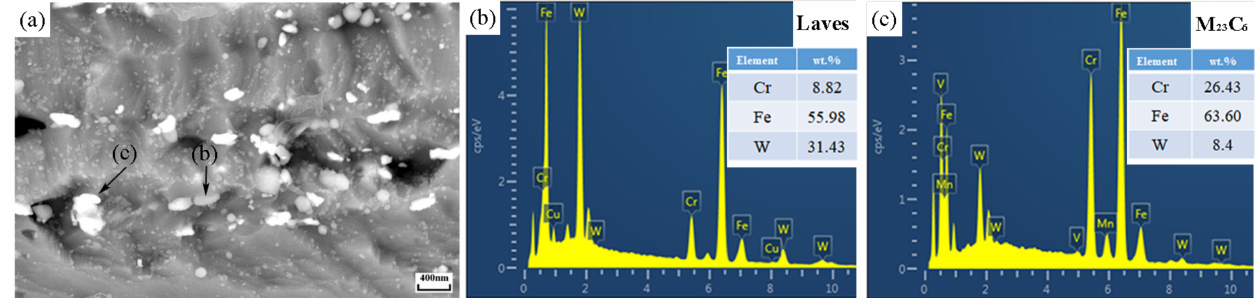
Figure 7. EDS characterization of Laves phase and M23C6: ( a ) Microstructure; ( b ) Laves; ( c ) M 23 C 6